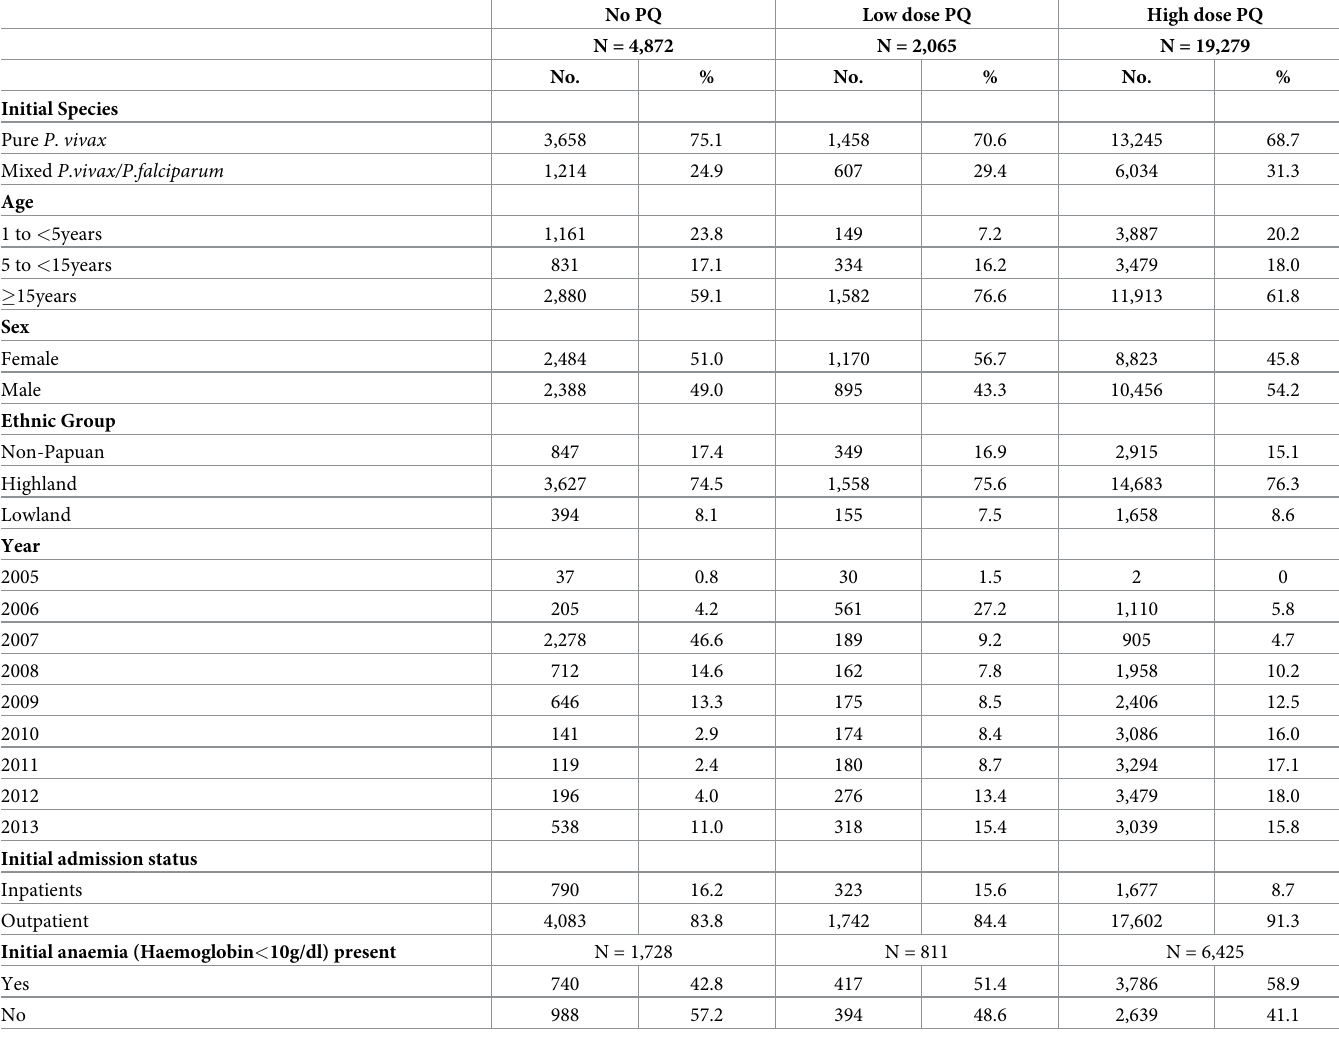
Table 1. Baseline demographics of the study